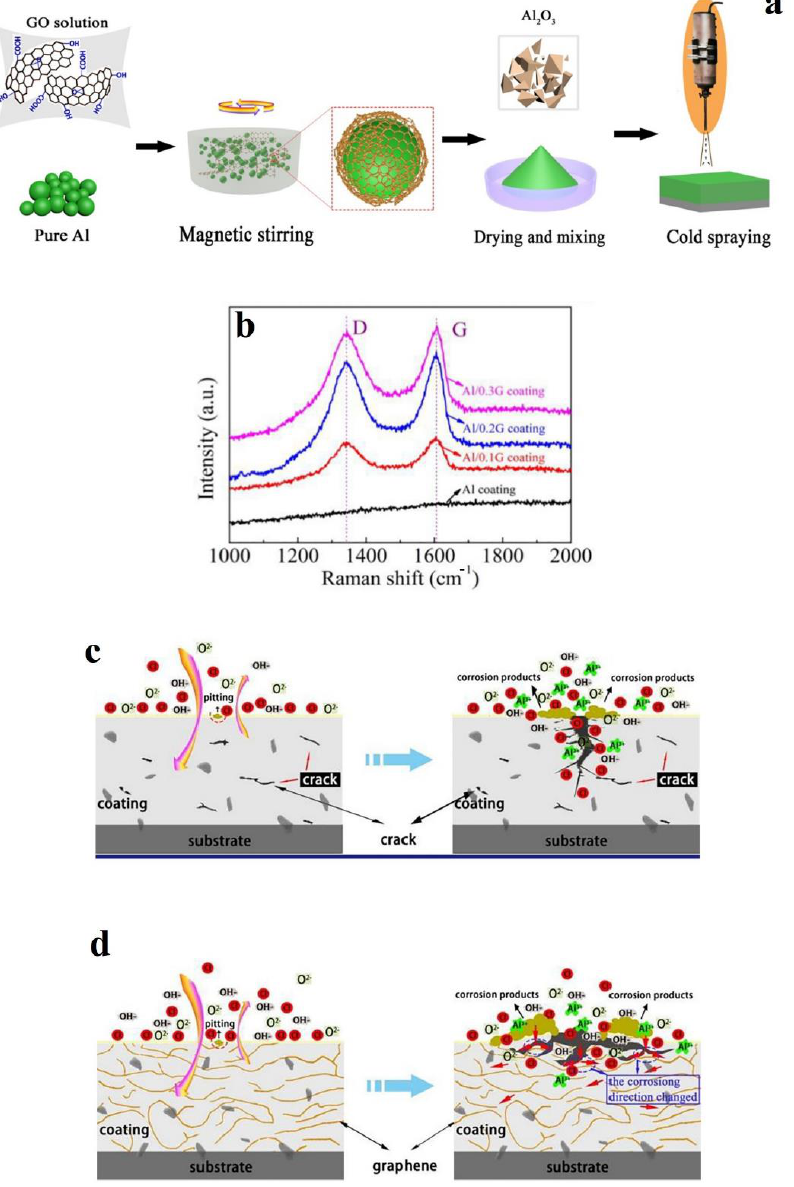
Figure 9. ( a ): Schematic of GO in situ reduction and CS, ( b ) Raman spectra, ( c ) mechanism of corrosion in pure Al coating, and ( d ) mechanism of corrosion in GNP/Al composite coating. Presented with permission from [71].